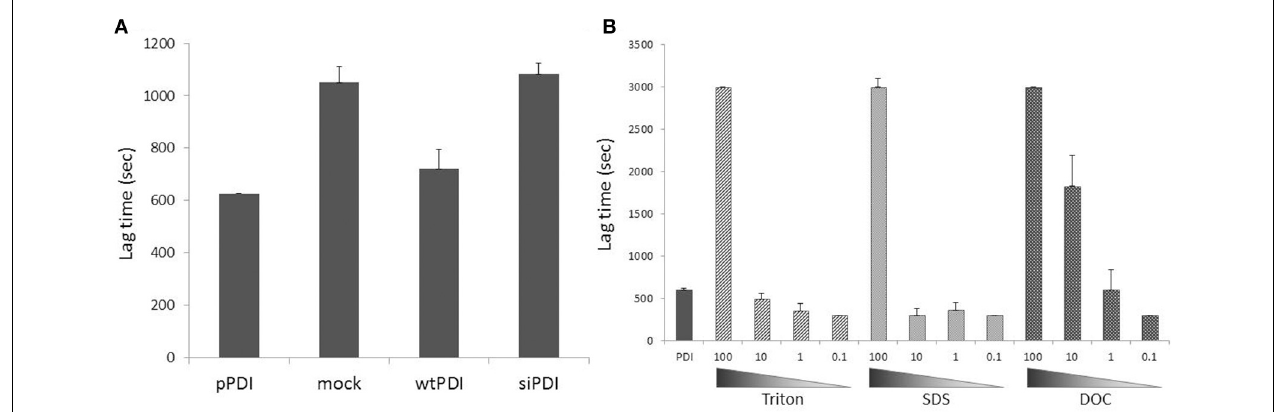
FIGURE 2 | Spurious inhibitors and detergents as PDI reductase assay interferents in biological samples. (A) PDI overexpression ( ∼ 3-fold increase vs. endogenous PDI) increased, while PDI silencing (by ca.70%) did not change insulin reduction in endothelial cell homogenates. Freshly prepared homogenates (150 µ g) obtained by mechanical lysis (in the absence of detergents) were incubated with insulin (1mg/mL) and PDI (1.5 µ M) in the presence of DTT (1.5mM) and insulin turbidity was assessed at 540nm. pPDI = purified PDI, mock = cells treated with transfection reagent, wtPDI = cells transfected with wild type PDI, siRNA = cells transfected with siRNA against PDI. Cells were lysed 24h after transfection procedure. Note the higher lag